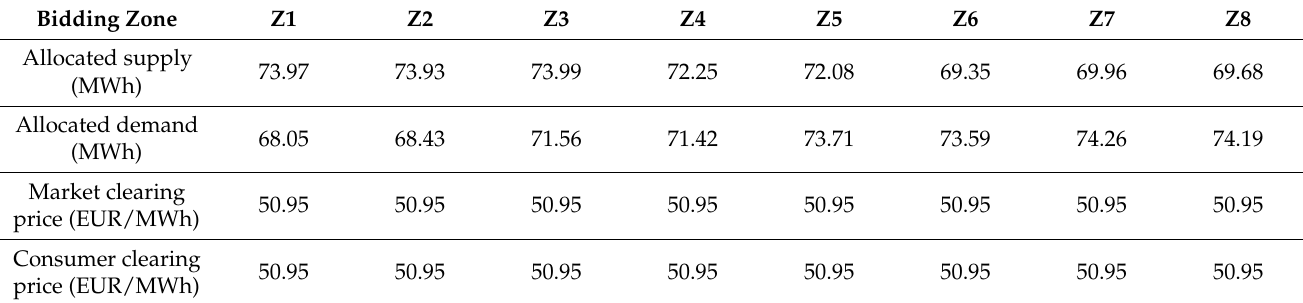
Table 4. Main clearing results of the second simulated